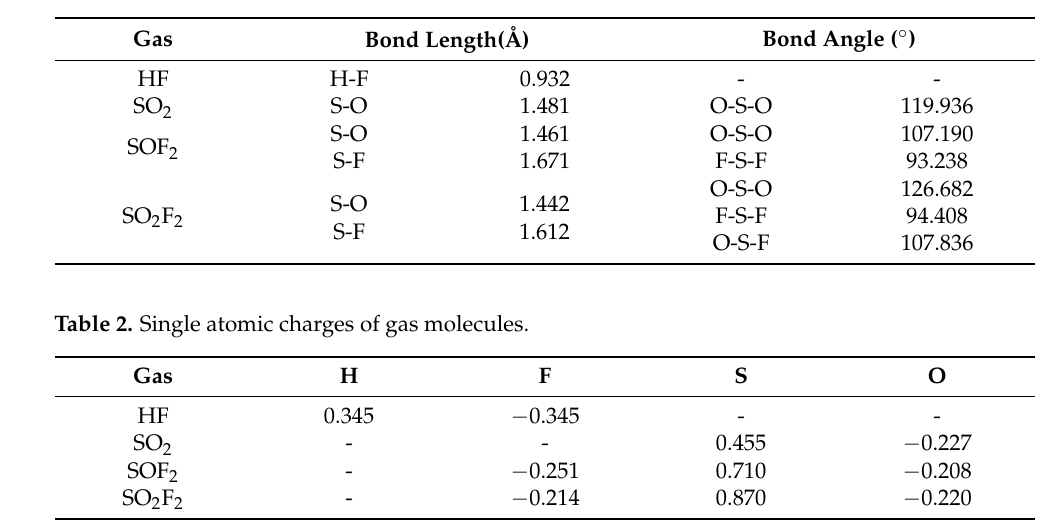
Figure 1. Optimized geometrical structures of ( a ) HF, ( b ) SO 2 , ( c ) SOF 2 and ( d ) SO 2 F 2 . Table 1. Geometrical parameters of HF, SO 2 , SOF 2 , and SO 2 F 2 .